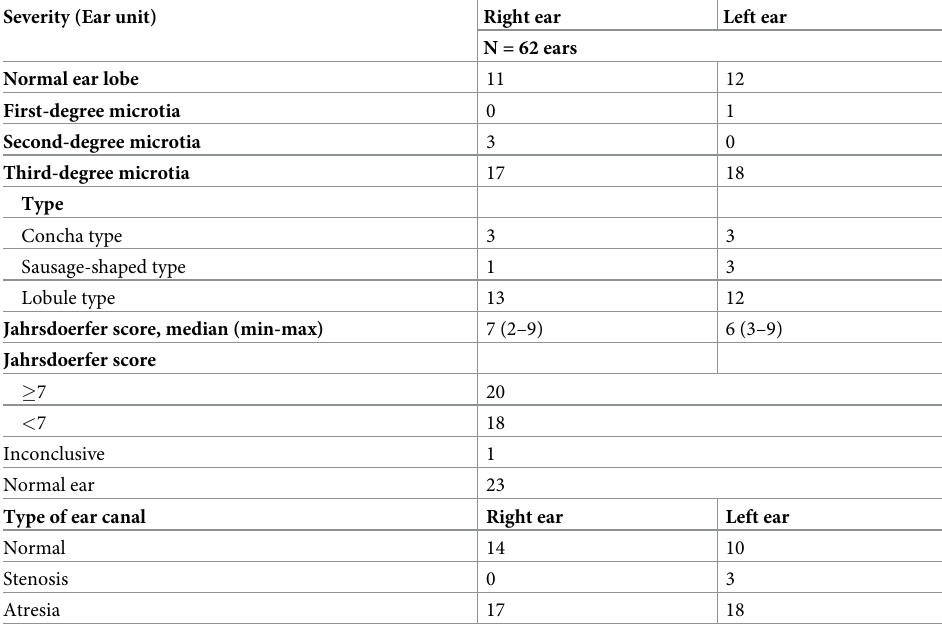
Table 1. Severity and type of microtia, Jahrsdoerfer score based on computed tomography results, and type of ear canal in the patients with microtia. Severity (Ear